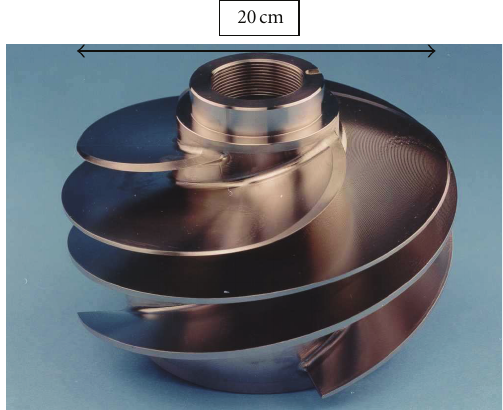
Figure 2: Inducer